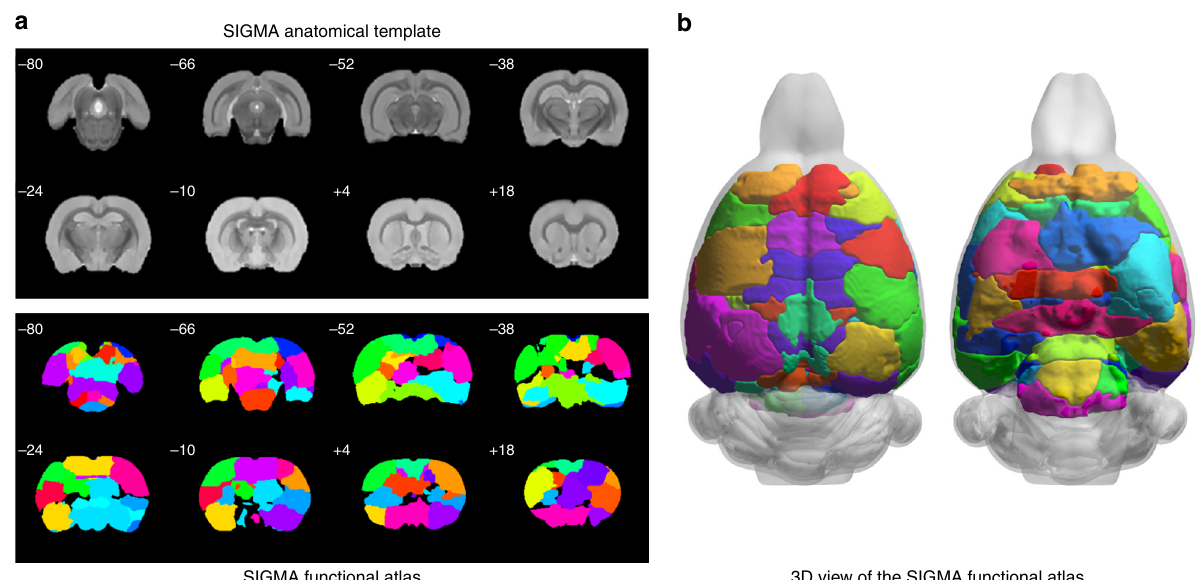
Fig. 6 The SIGMA functional atlas of rat brain. a Coronal slices of the ex vivo SIGMA anatomical template of the rat brain and the corresponding slices of the SIGMA functional atlas and b 3D representation of the SIGMA functional